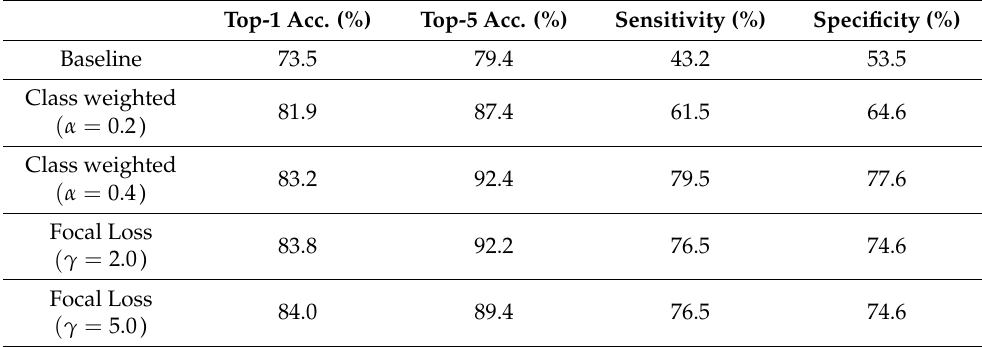
Table 3. Performance evaluation on PlantCLEF 2015 test set. Top-1 Acc. (%) Top-5 Acc. (%) Sensitivity